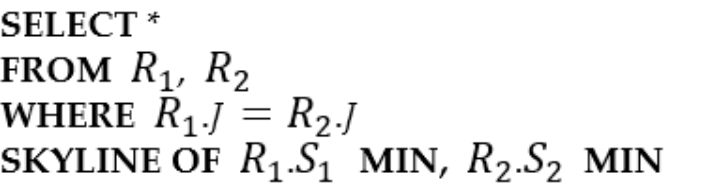
Figure 4. Query 𝑄 (cid:3037) . Figure 4. Query Q j .